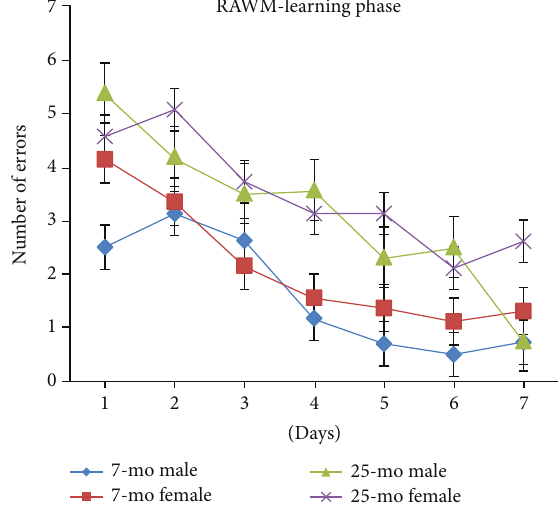
Figure 5: Number of errors of 7- and 25-month-old C57BL/6 male and female mice in learning phase of RAWM (mean ±